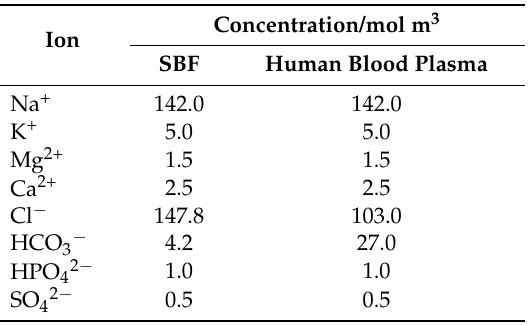
Table 1. Simulated body fluid (SBF)